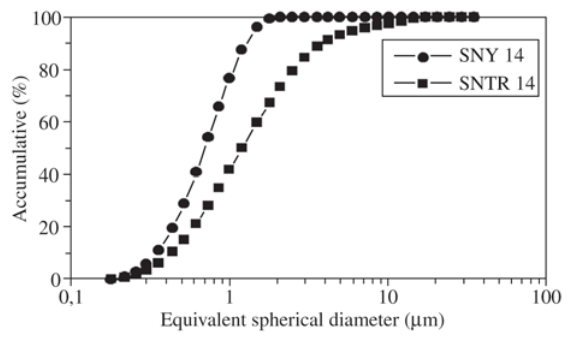
Figure 2. Particle size distributions of the SNY14 and SNTR14 powder